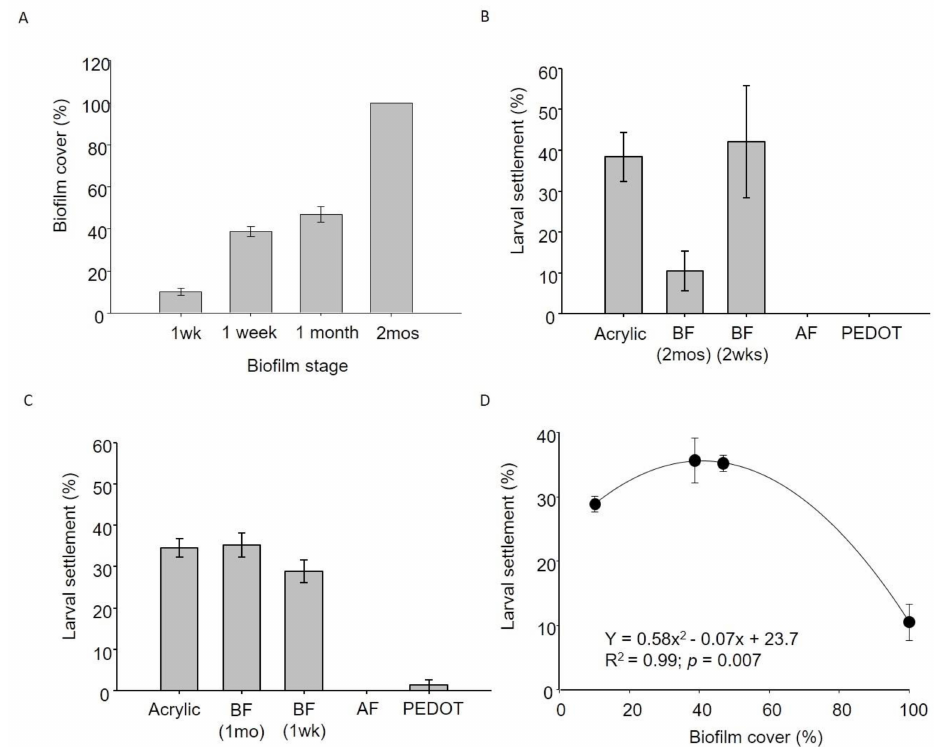
Figure 3. ( A ) Biofilm deposition cover (%) on acrylic plates calculated from the image analysis of the four different stages of biofilm, ( B ) proportion of barnacle settlement in the 5 experimental plates for the experiment 1, ( C ) proportion of barnacle settlement in the 5 experimental plates for the experiment 2, ( D ) results from the polynomial quadratic OLS regression between larval settlement (mean ± SE) and biofilm cover. BF = biofilm; AF = antifouling paint. Experimental time: 1